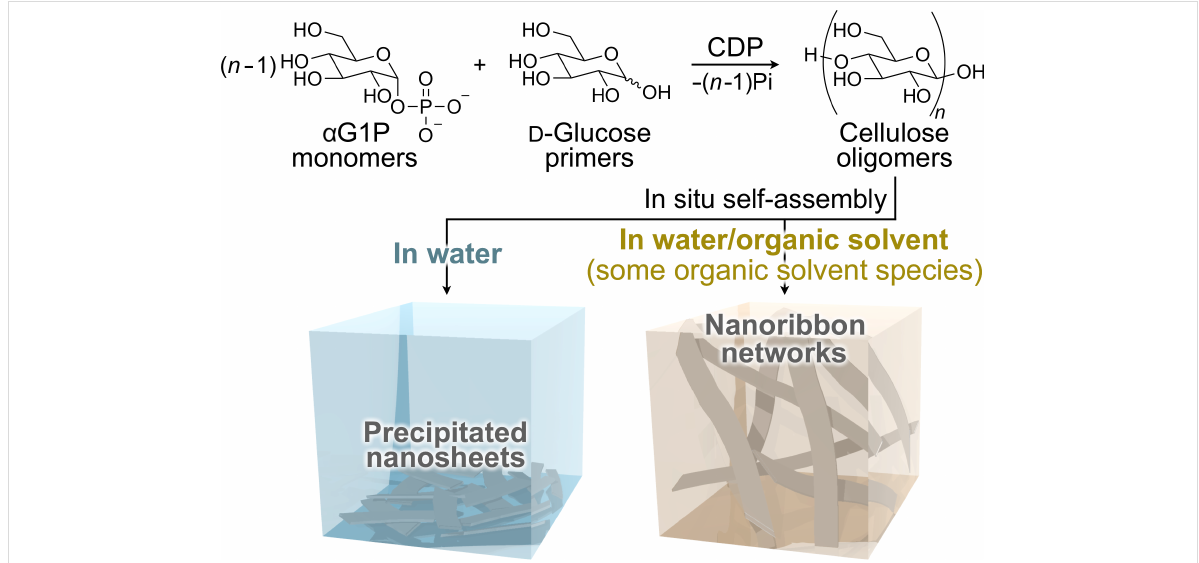
Figure 1: Reaction scheme of the CDP-catalyzed oligomerization and schematic illustrations of cellulose oligomer assemblies produced in aqueous buffer solutions and in mixtures of an aqueous buffer solution and appropriate organic solvents.